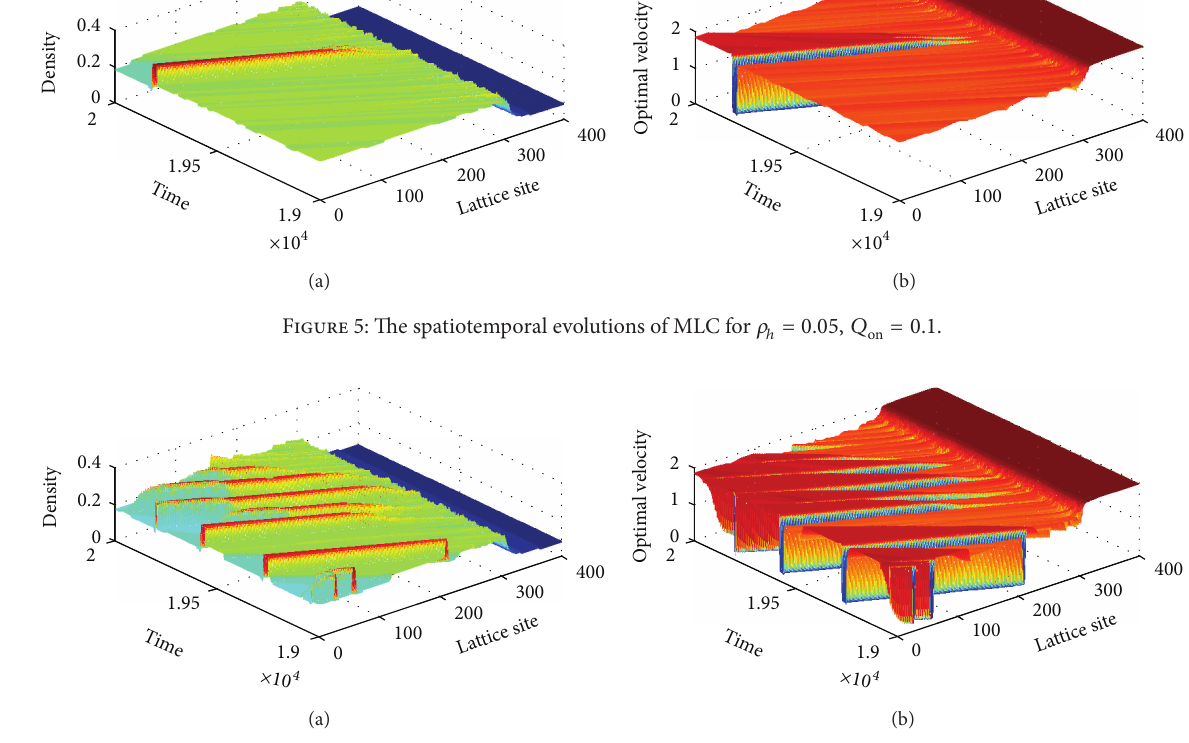
Figure 6: The spatiotemporal evolutions of TSG for 𝜌 ℎ = 0.07 , 𝑄 on = 0.11